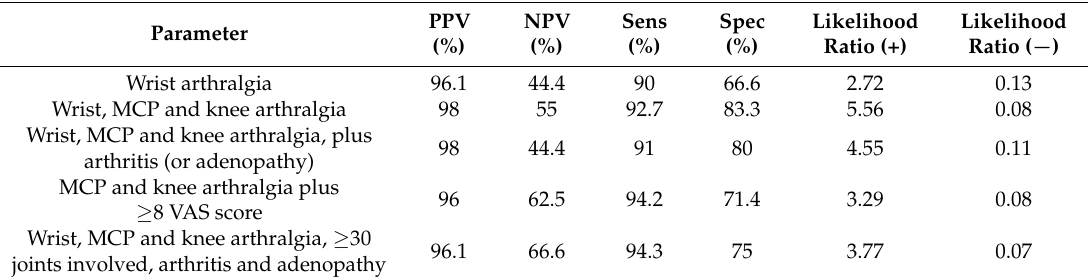
Table 4. Clinical features used to distinguish patients with Chikungunya fever from patients with AUFI a